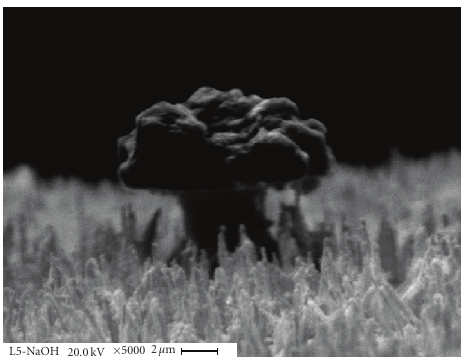
Figure 4: Typical top view SEM images of Co “mushroom” grown by AC treatment of oxalic acid alumina template in the solution of this study. Before deposition the thickness of alumina barrier layer was reduced by lowering the anodizing voltage ( U a ) down to final value ( U a ,fin ) equal to 15 V.